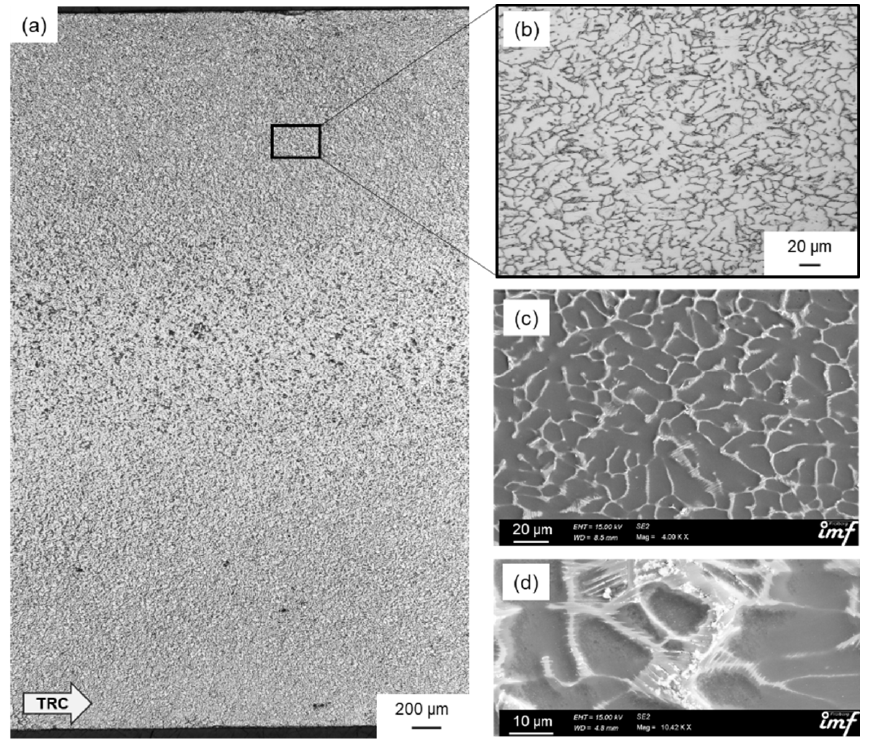
Figure 1. Microstructure of the twin-roll cast and homogenized WZ73 alloy: Optical micrographs showing ( a ) an overview over the cross section of the strip and ( b ) a detail at the top of the strip and SEM micrographs of the detail in ( c , d ) network-like LPSO phase.